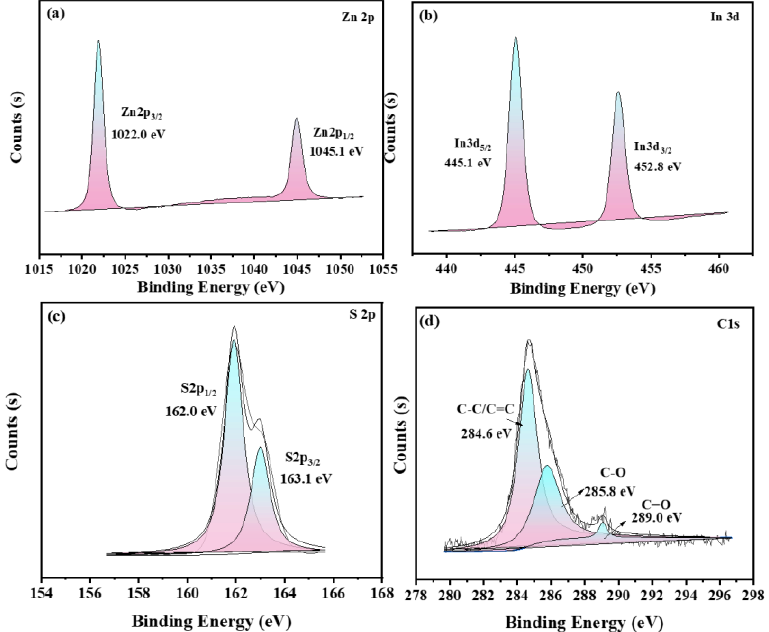
Figure 2. XPS spectra of the CQDs/ZnIn 2 S 4 -2: high-resolution scans of ( a ) Zn 2p, ( b ) In 3d, ( c ) S 2p, and ( d ) C 1s.